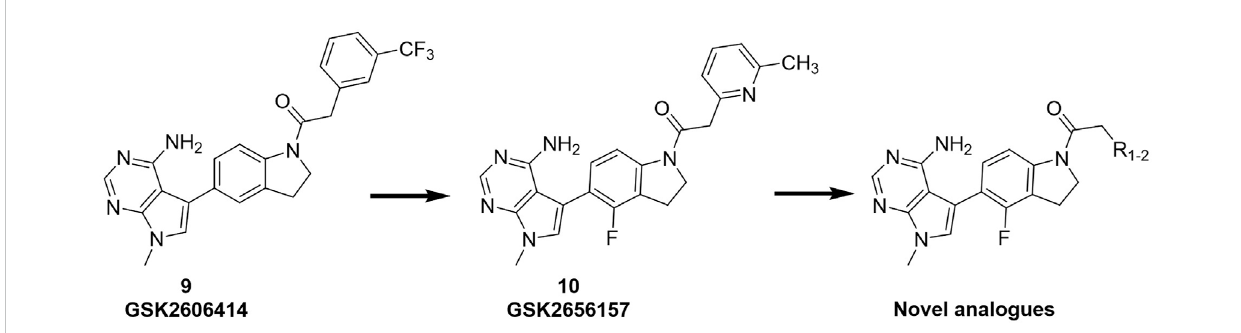
FIGURE 2 Overview of the novel GSK ’ 157 analogues featuring a substituent on corresponding para-position or the pyridinyl or aryl